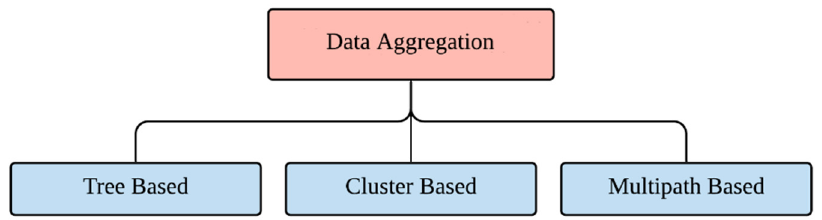
Figure 8. Process of the data aggregation phase.